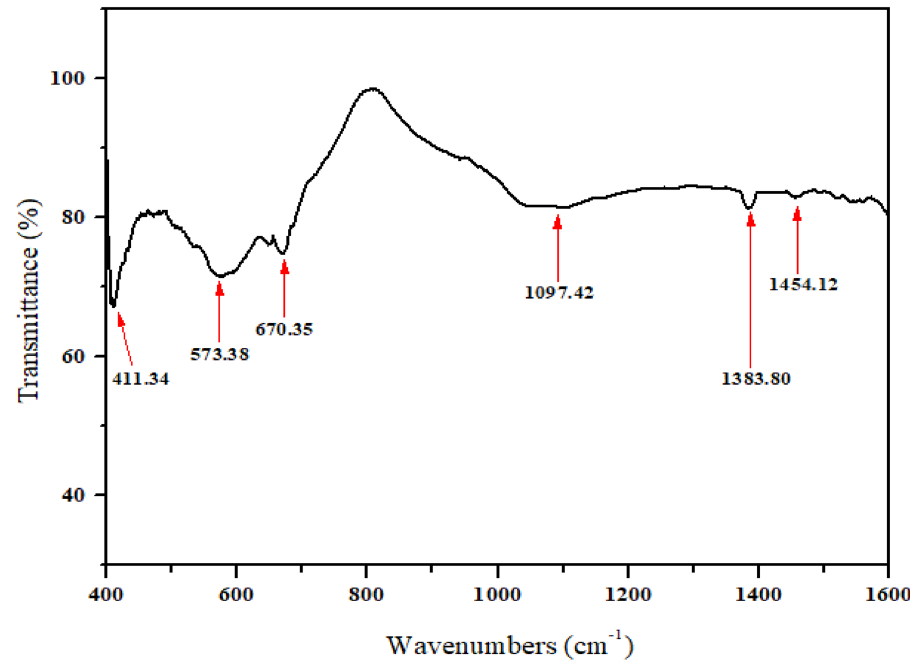
Figure 4. FTIR spectra of nickel zinc ferrite (Ni 0.5 Zn 0.5 Fe 2 O 4 ) sintered at 1200 °C.